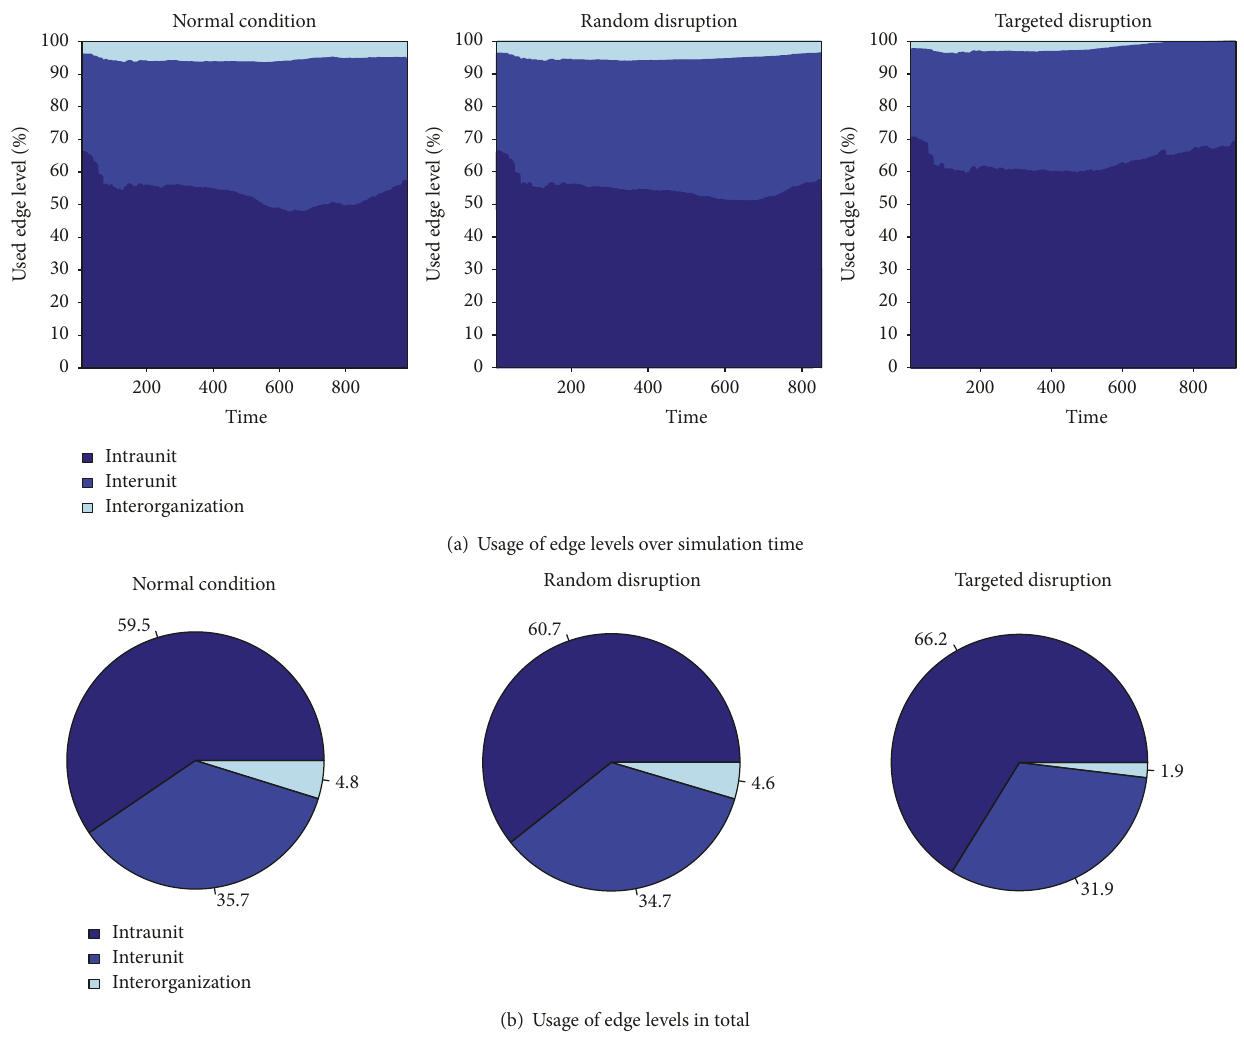
Figure 8: Levels of edges used in normal and disrupted